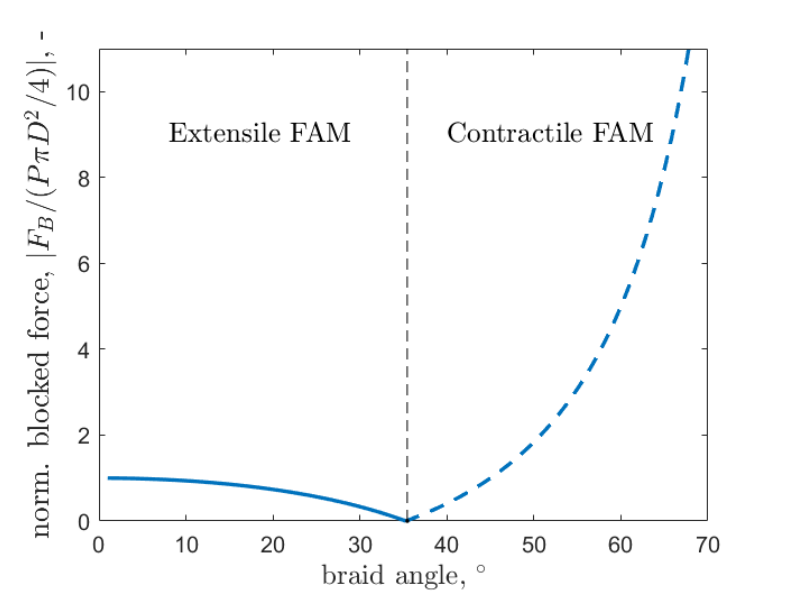
Figure 3. The relationship between the absolute normalized blocked force of Gaylord’s model and the resting braid angle. A FAM blocked force is non-linearly dependent on its resting braid